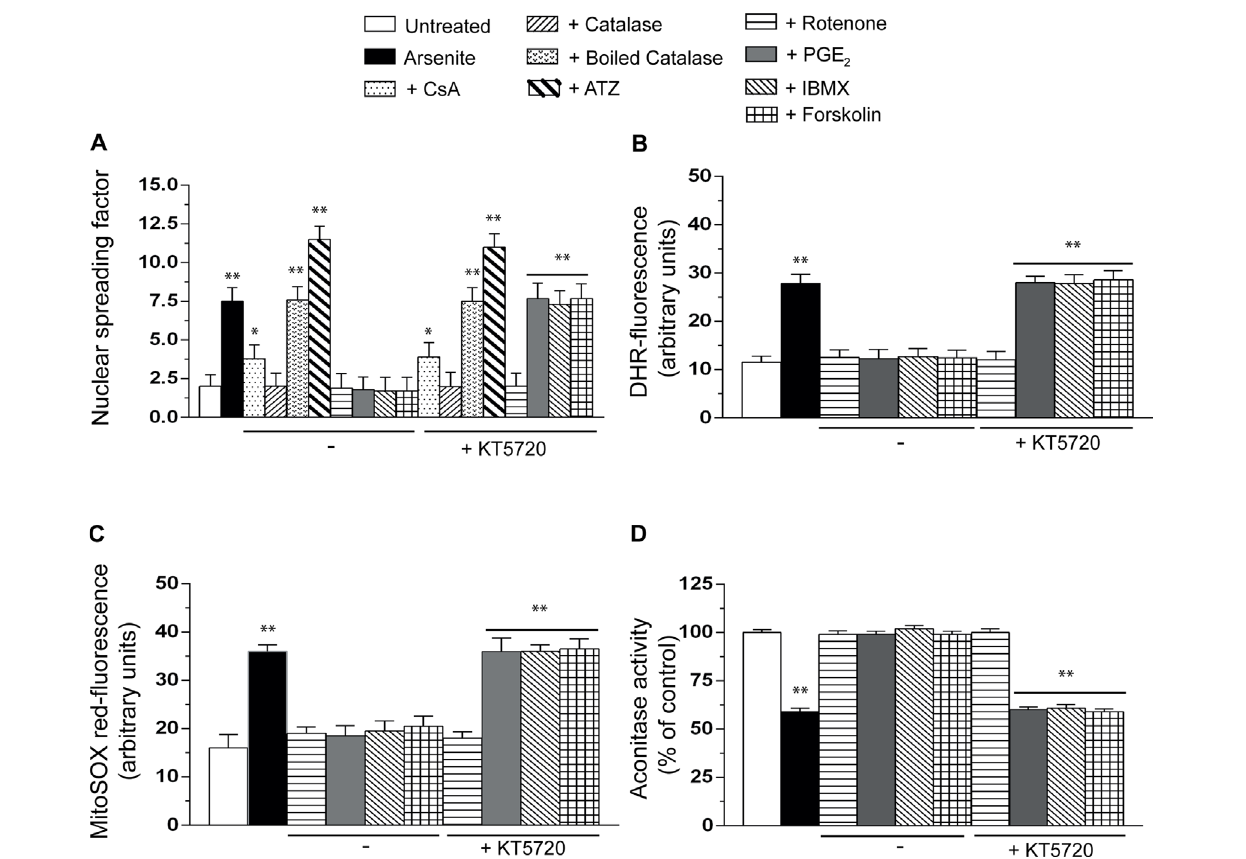
FIGURE 4 | PGE 2 prevents the formation of mitoO 2−. induced by arsenite and the ensuing mitochondrial and extramitochondrial effects. Cells were exposed for 16 h to arsenite, in the absence or presence of CsA, enzymatically active or heat-inactivated catalase (50 U/ml), rotenone (0.5 µ M), PGE 2 , IBMX, forskolin, or KT5720, as indicated in the figures. In other experiments, the cells were incubated for 6 h with 10 mM 3-amino-1,2,4,-triazole (ATZ) and subsequently treated with arsenite. After treatments, the cells were analyzed for DNA damage (A) , dihydrorhodamine 123 (DHR_ fluorescence (B) , MitoSOX red fluorescence (C) , and aconitase activity (D) . Results represent the means ± SD calculated from at least three separate experiments. * p < 0.05; ** p < 0.01, as compared with untreated cells (one-way ANOVA followed by Dunnett’s